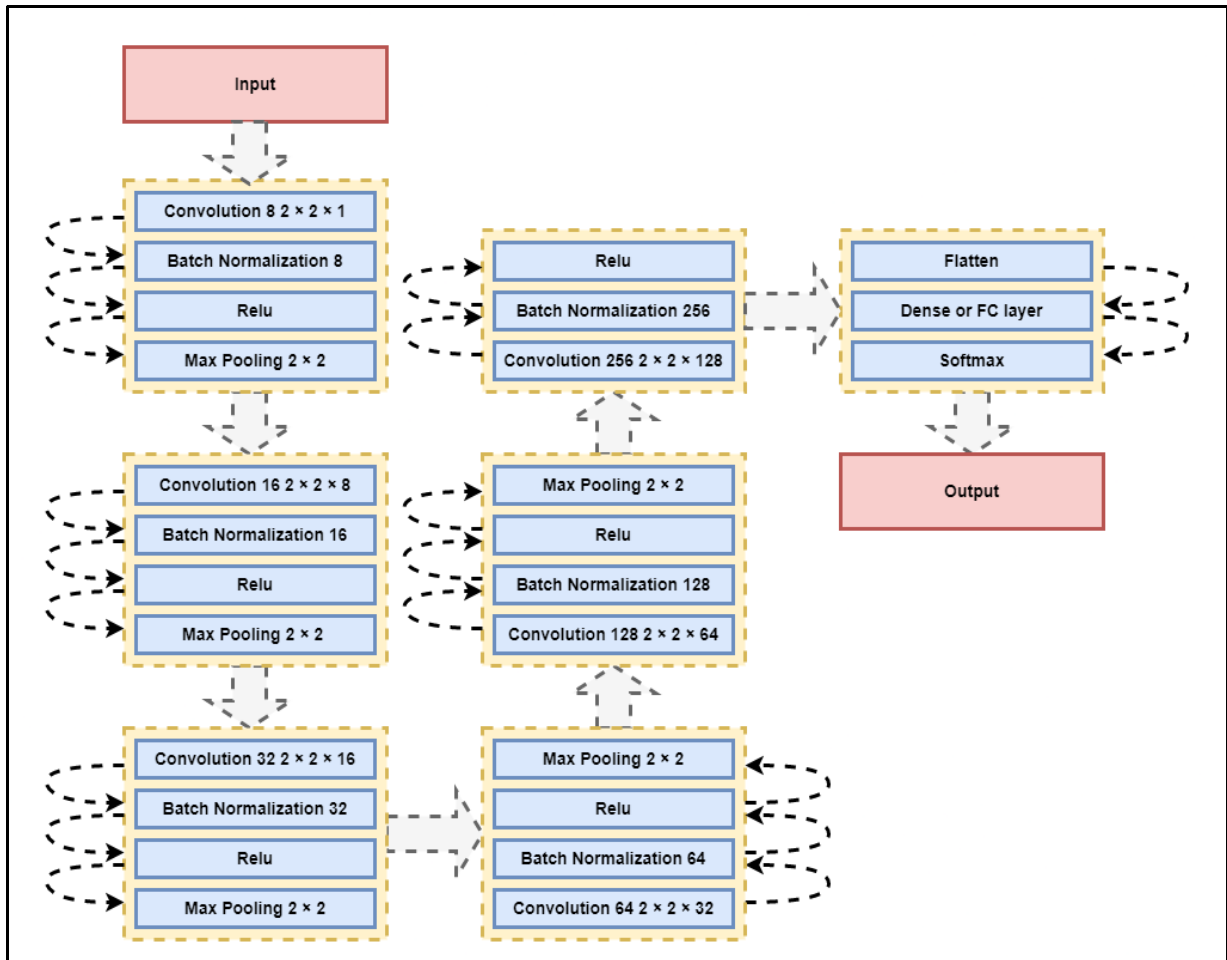
Figure 6. Configuration of deep learning model used in this study.